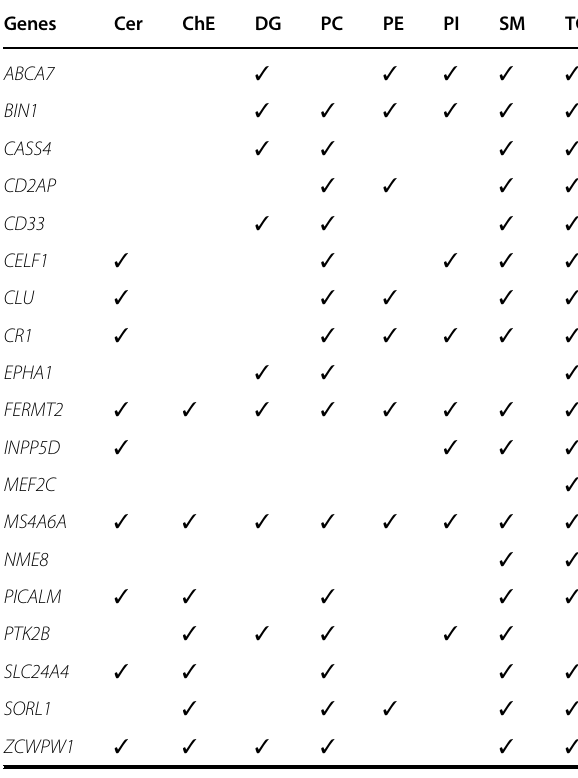
Table 4 Differential interaction of genes with lipids between AD and control.